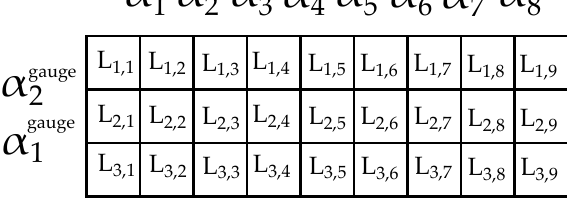
+ L SU(9) , where L k i j